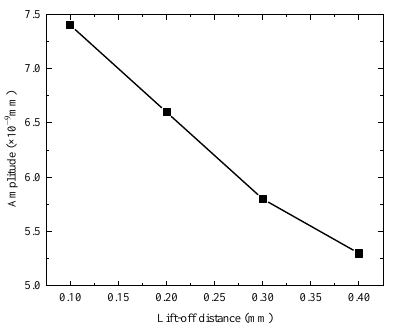
Figure 19. The influence of lift-off distance on the amplitude of received signal.